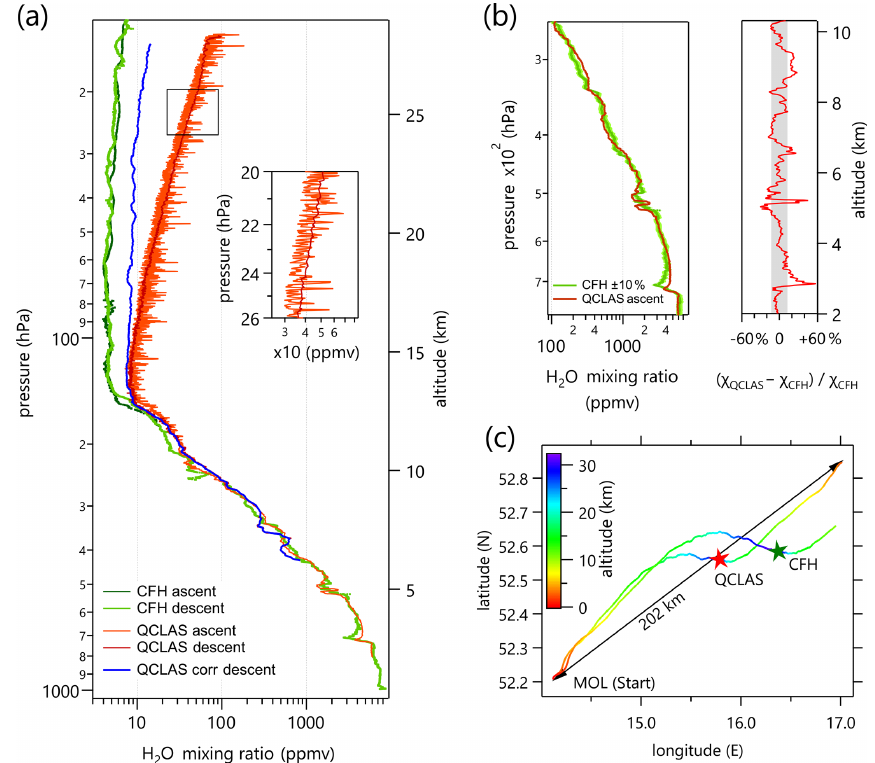
Figure 7. (a) H 2 O volume mixing ratio profiles measured by QCLAS and CFH during ascent and descent. The inset shows the unilateral spikes on top of a slowly varying signal in the stratosphere. An attempt to correct for the spurious absorption caused the internal OPL is shown by the blue curve (see main text for details). (b) Close-up of the tropospheric measurements; the relative deviation is plotted in the right panel, showing a standard deviation of 13% (gray area) among the instruments. (c) Flight trajectories and burst points – the two balloons were launched with a time lag of